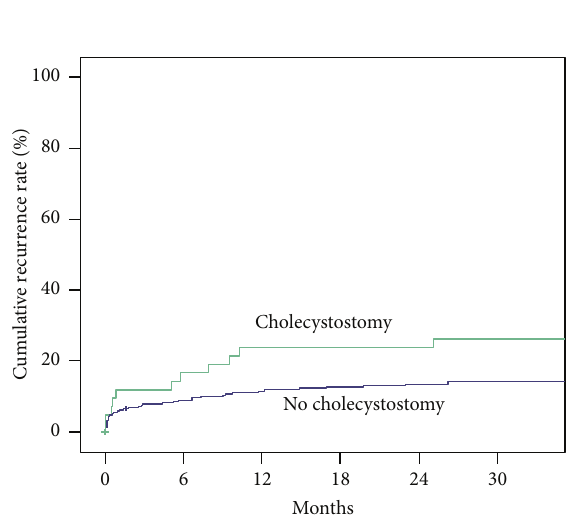
Figure 1: Cumulative recurrence rate after the first admission for patientstreatedwithcholecystostomyandpatientstreatedconserva- tively without intervention. The Kaplan-Meier plot was constructed by defining readmission for recurrent cholecystitis as terminal event and end of follow-up (December 31, 2011), death, or planned cholecystectomy as censored events. The difference between the groups was not statistically significant in univariate ( 𝑃 = 0.056 ) or multivariate ( 𝑃 = 0.051 ) Cox proportional hazard analysis with adjustment for age, gender, Charlson comorbidity index, and degree of